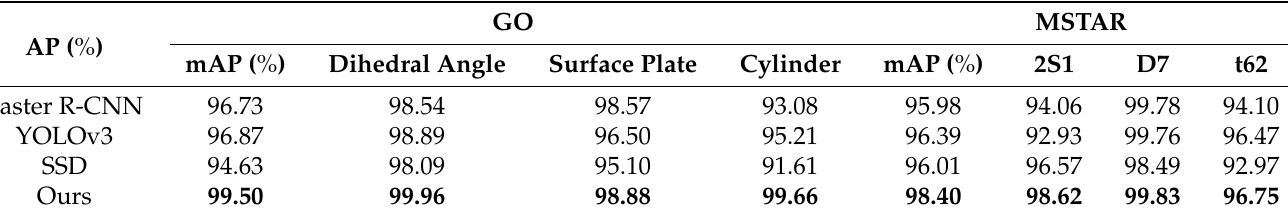
Table 3. Comparison among other detection methods.